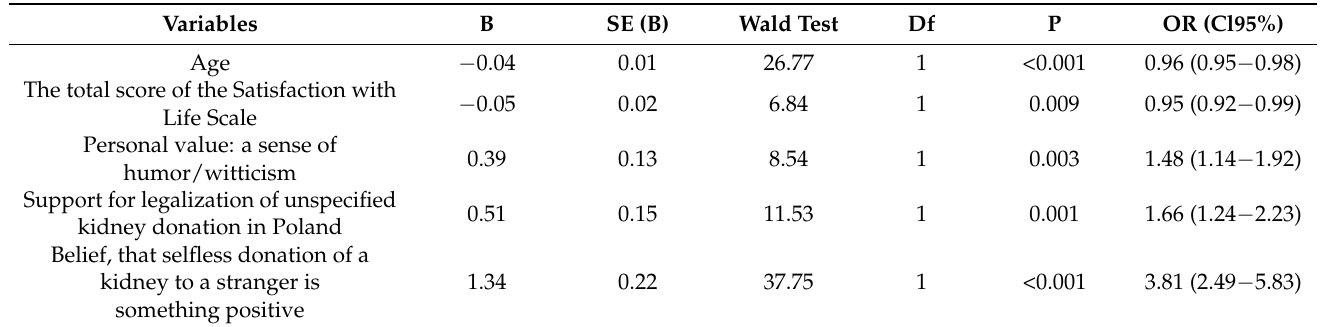
Table 4. Factors determining kidney donation willingness to a stranger (multivariate model of logistic